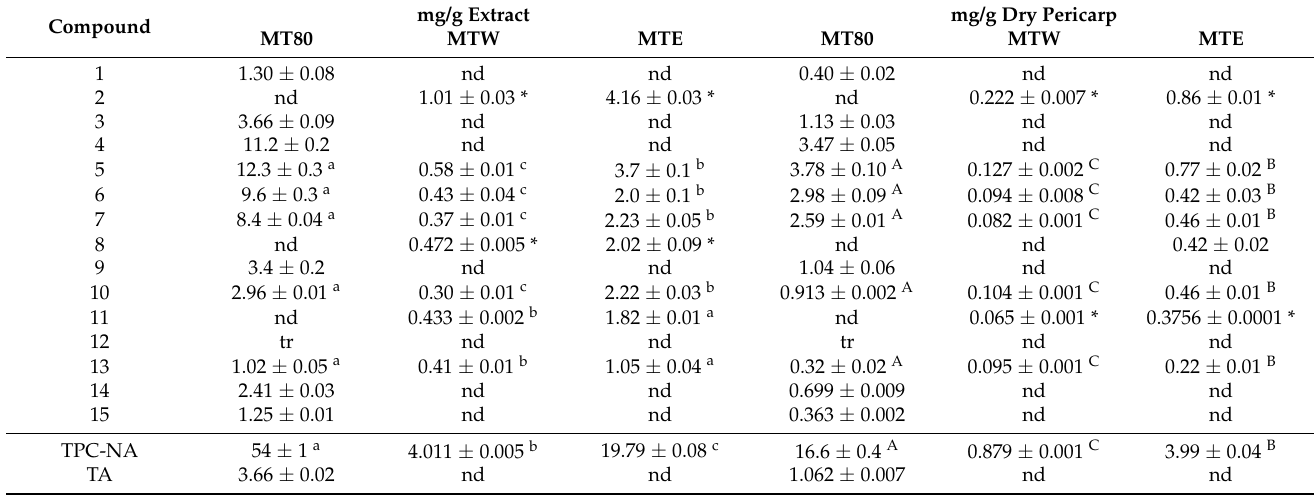
Table 3. Quantification of phenolic compounds detected in different extracts of the mangosteen pericarp. mg/g Compound